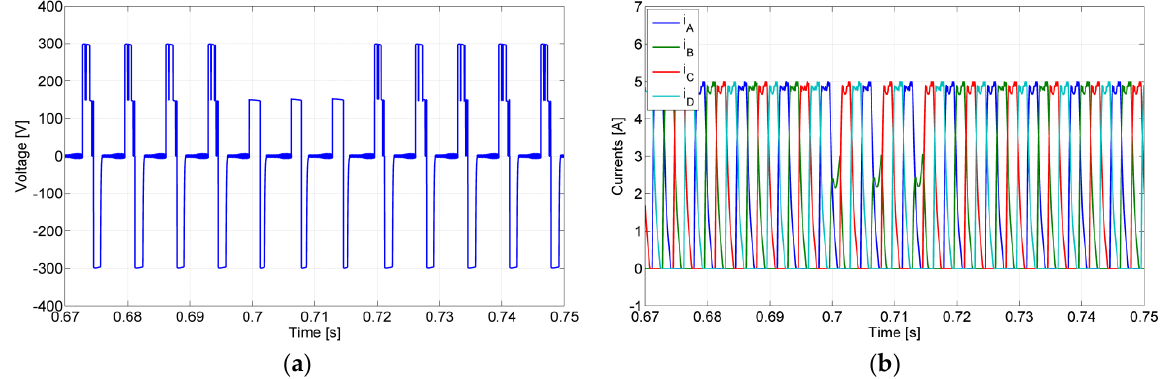
Figure 10. Simulation test with the converter operating in normal mode until t = 0.695 s and after that with an open-switch fault in the semiconductor S 12 ( a ) winding voltage of phase B ; ( b ) winding currents. Fault-tolerant mode after t = 0.715 s.